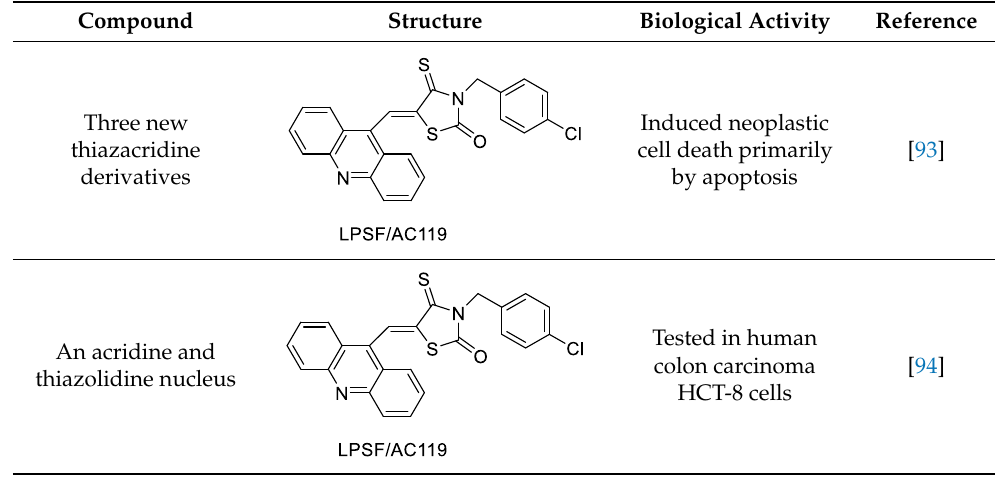
Figure 12. SAR of thiazacridine derivatives. Table 14. Thiazacridine as an anti-tumour Table 14. Thiazacridine as an anti-tumour agent.